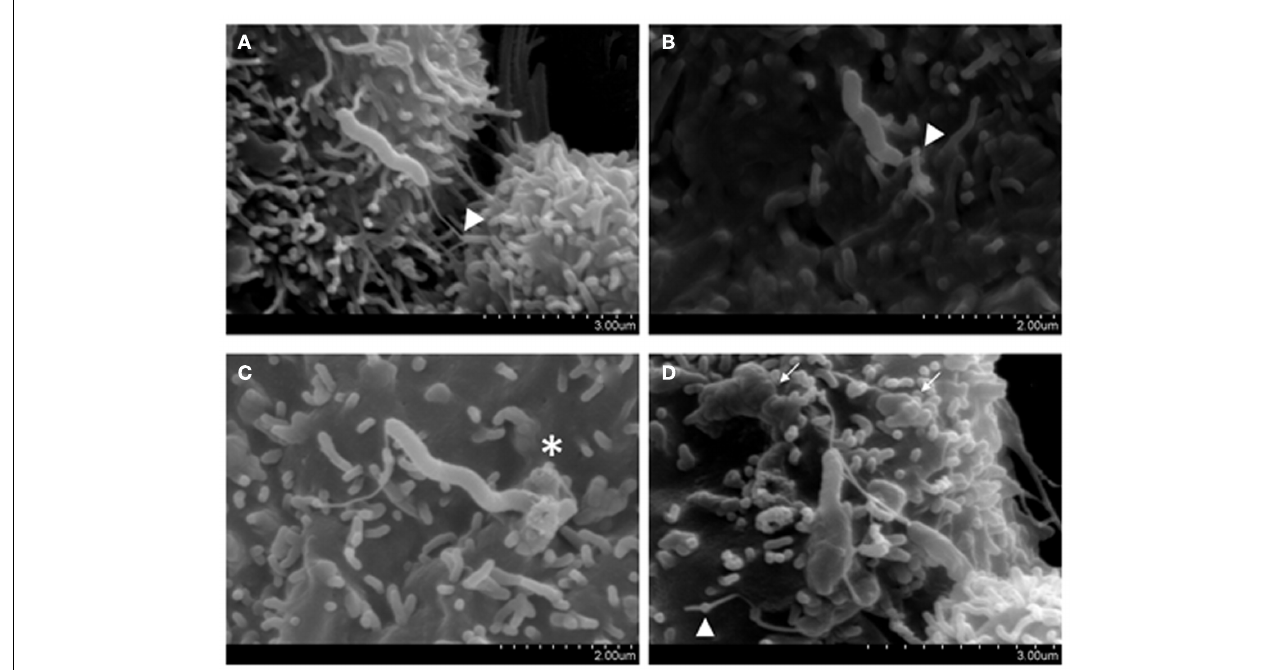
induced a membrane ruffling-like effect (*). (D) C. concisus is observed half internalized in the host cell, resulting in a surface protrusion on the host cell membrane, and the flagellated half remains externally exposed. A host cell infected with multiple bacteria displays cell membrane irregularities and uneven texture because of bacteria-induced protrusions ( arrows